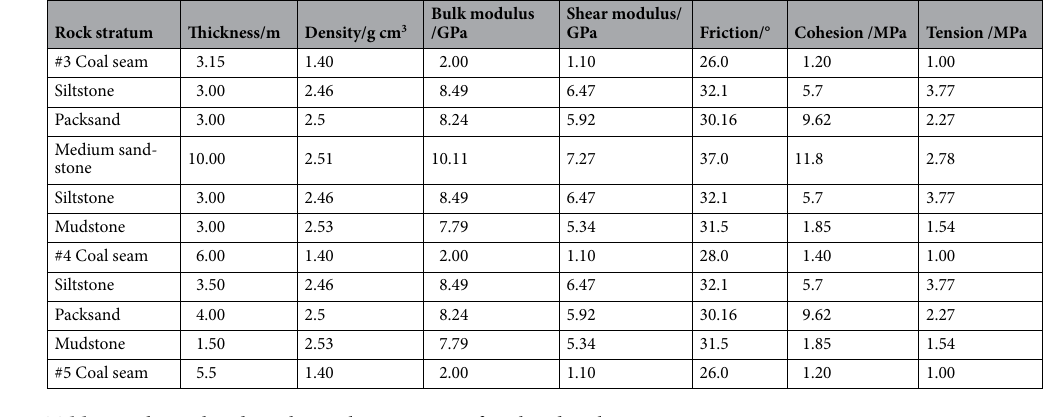
Table 2. Physical and mechanical parameters of coal and rock.